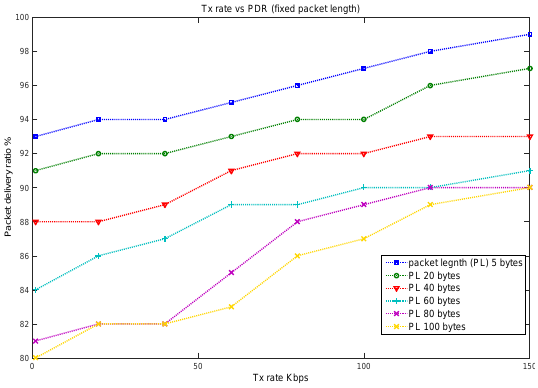
Table 5: Optimum values of physical and network parameters obtained from experiments